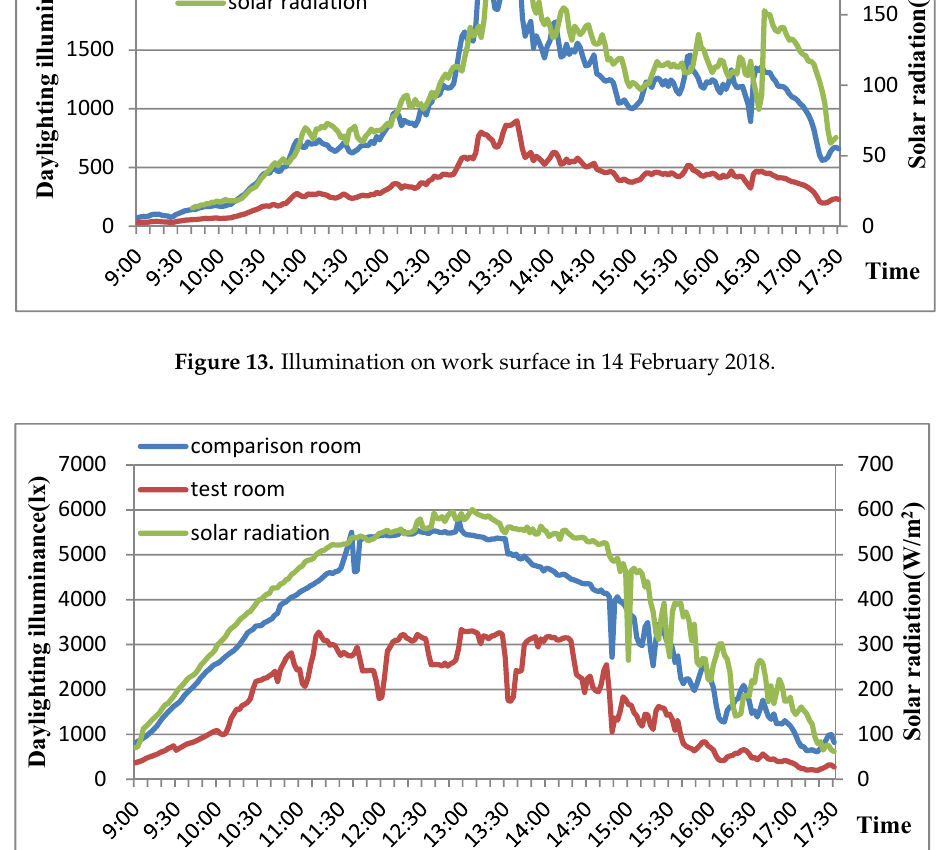
Figure 14. Daylight illuminance on work surface in 15 February 2018.